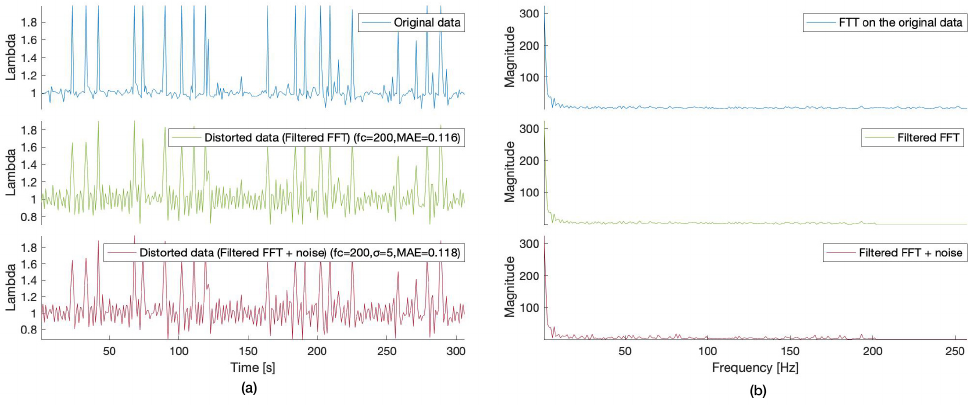
Figure 2. 1D FFT-based data distortion for the Lambda sensor data ( f c -cut-off frequency, σ -discord, MAE -Mean Absolute Error): original data values (blue), filtered values in frequency domain (green), filtered and perturbed values in the frequency domain using additive Gaussian noise (red). ( a ) Time domain. ( b ) Frequency